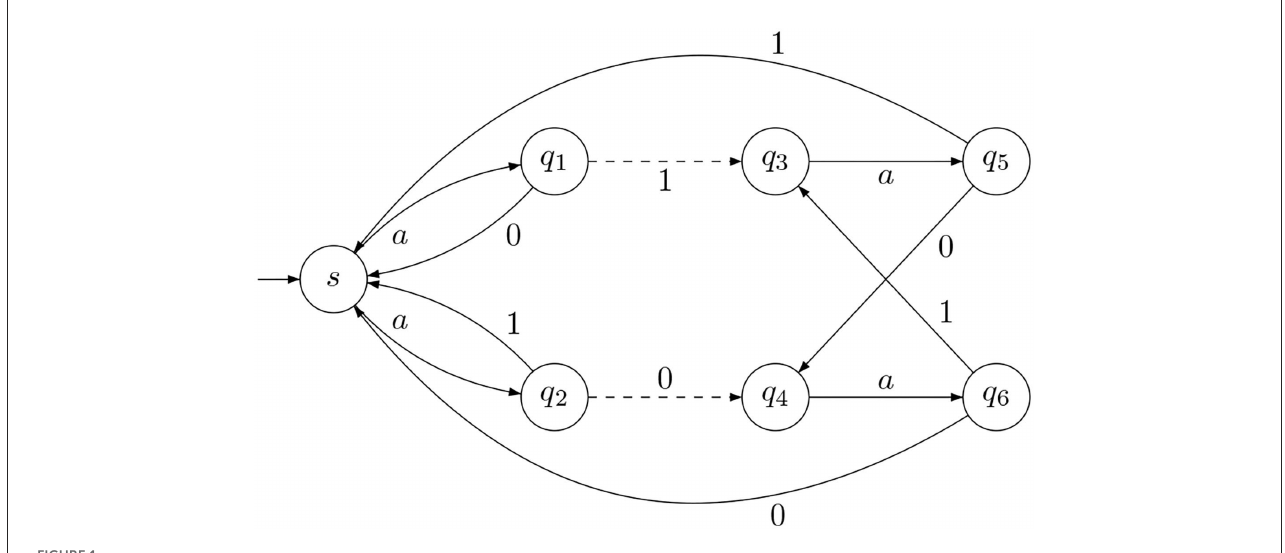
FIGURE1 A HD-tNBW that is not DBP. Dashed transitions are in α